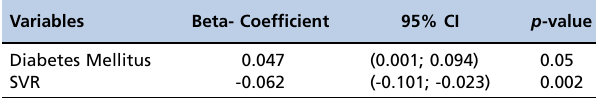
Table 3 - Independent factors related to the rate of progression of LS in HCV-infected patients (n=406).